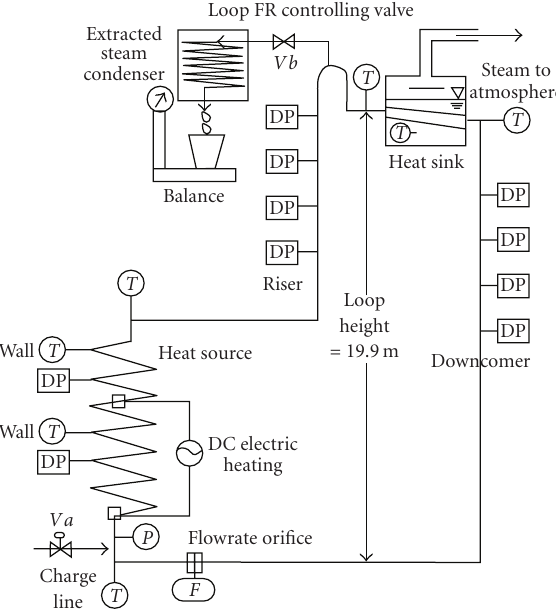
Figure 2: Sketch of IRIS EHRS Simulator facility (IES) at SIET labs.